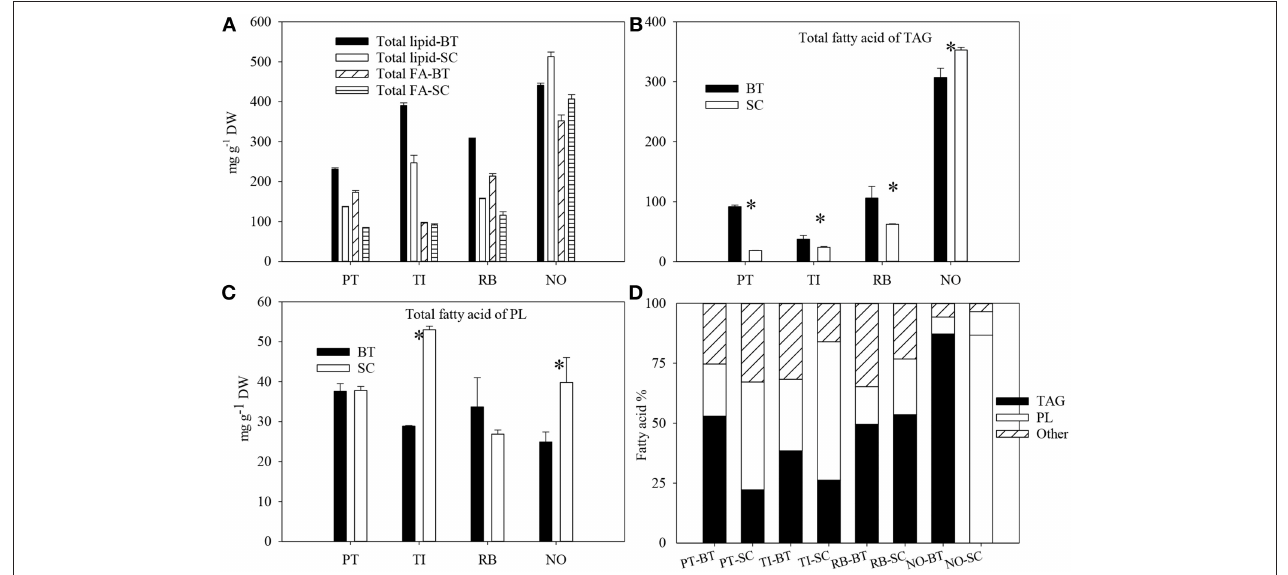
( Table 3 ). The fatty acids 16:0, 18:1n-9, 18:2n-6, 18:4n-3, and 22:6n-3 were the dominating fatty acids of TAG in T-Iso, and only 18:4n-3 increased with increasing N-limitation ( p <